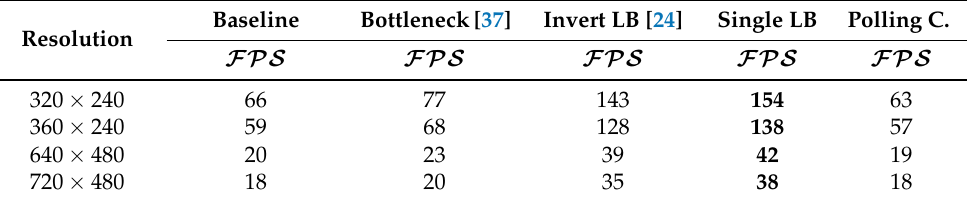
Table 6. Experimental results of inference efficiency for different bottlenecks and pooling compensa- tion. The best results are marked in